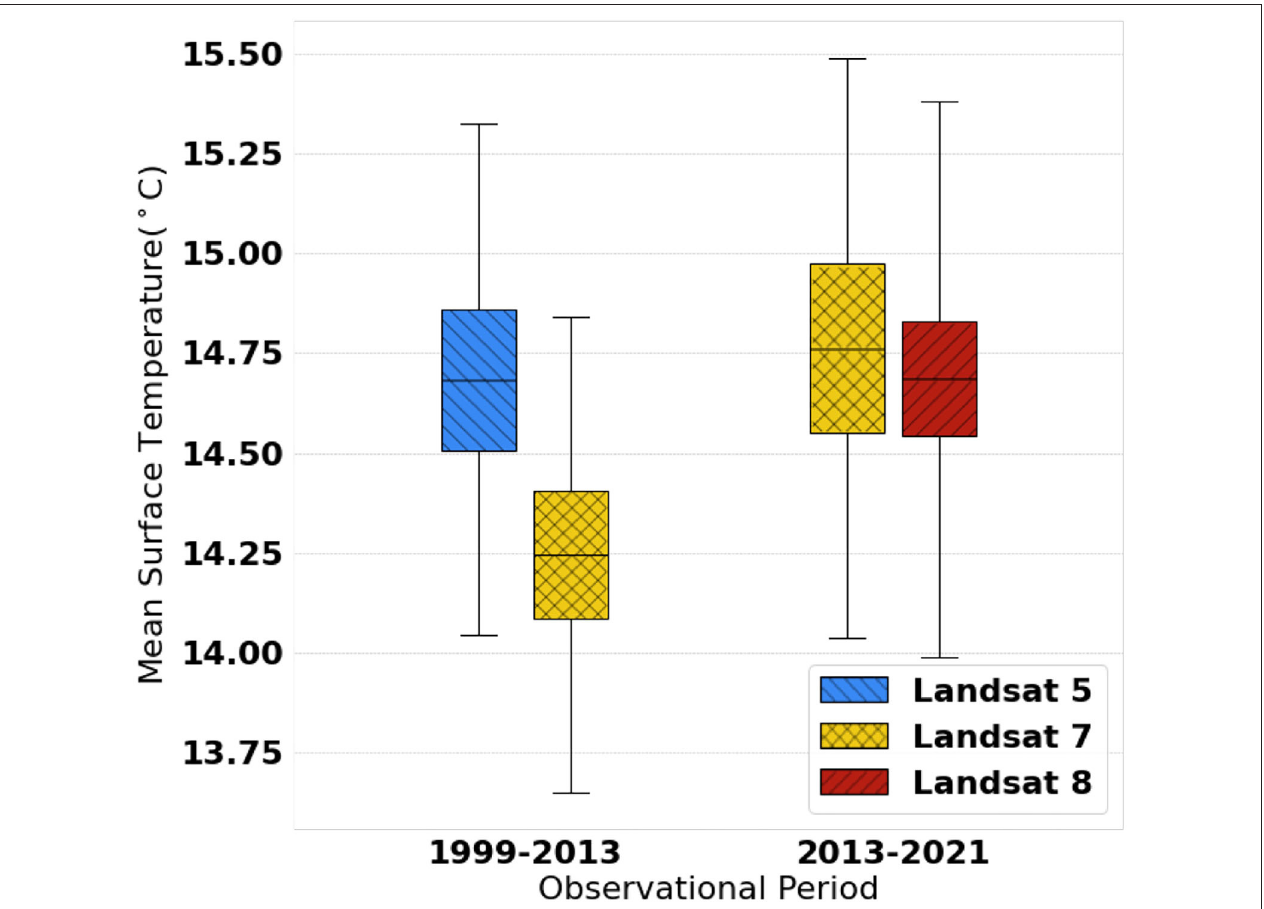
FIGURE 3 | Assessment of inter-satellite calibration by comparing surface temperature averaged over all of Narragansett Bay for overlapping time periods of each satellite. The central bars represent the means while the box edges represent propagated measurement uncertainty (from Table 1 ) and the whiskers represent sampling uncertainty estimated by